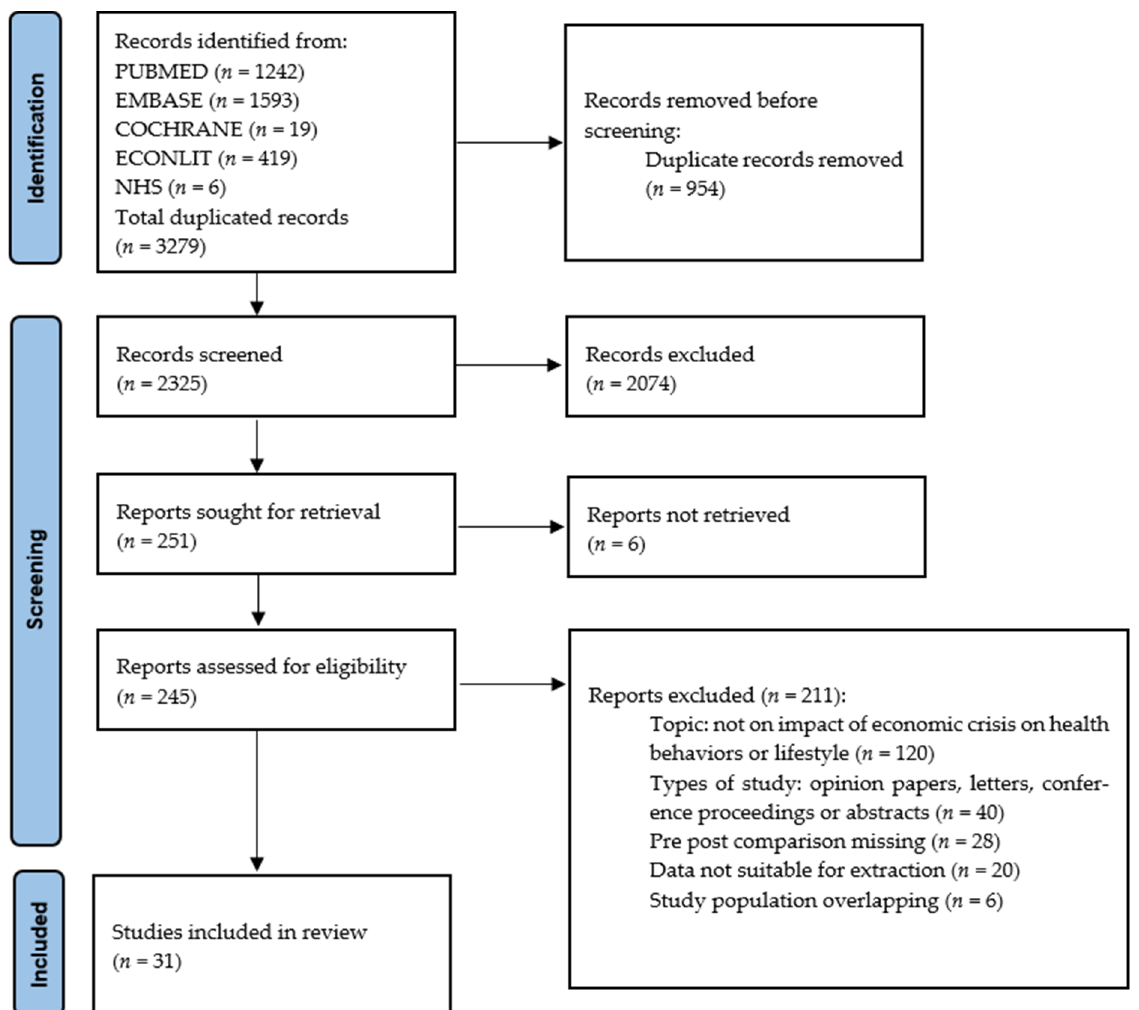
Figure 1. PRISMA flow diagram.